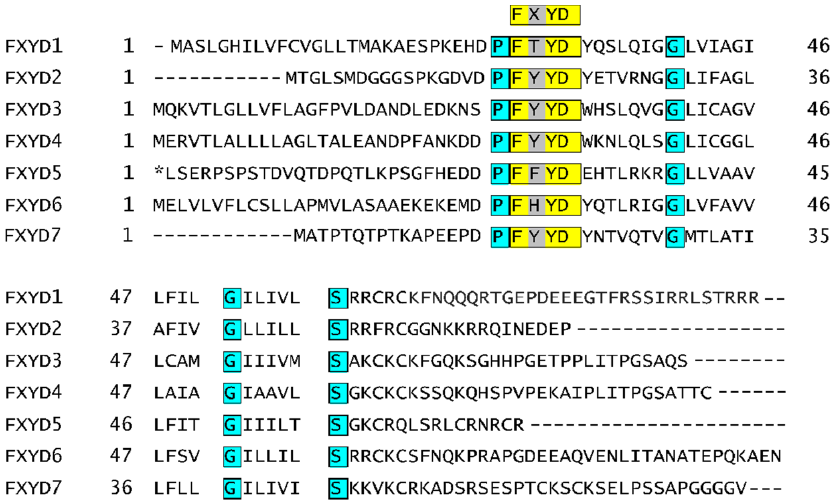
Figure 2. Amino acid sequence alignment of seven human isoforms of FXYD subunit of Na + /K + -ATPase. A conservative FXYD sequence is highlighted in yellow. Other shared amino acids are in turquoise. An elongated N-terminus present in isoform 5 is depicted in italics. The sequences were taken from refs. [41 – 47]. * N-terminal extension of FXYD5 isoform.